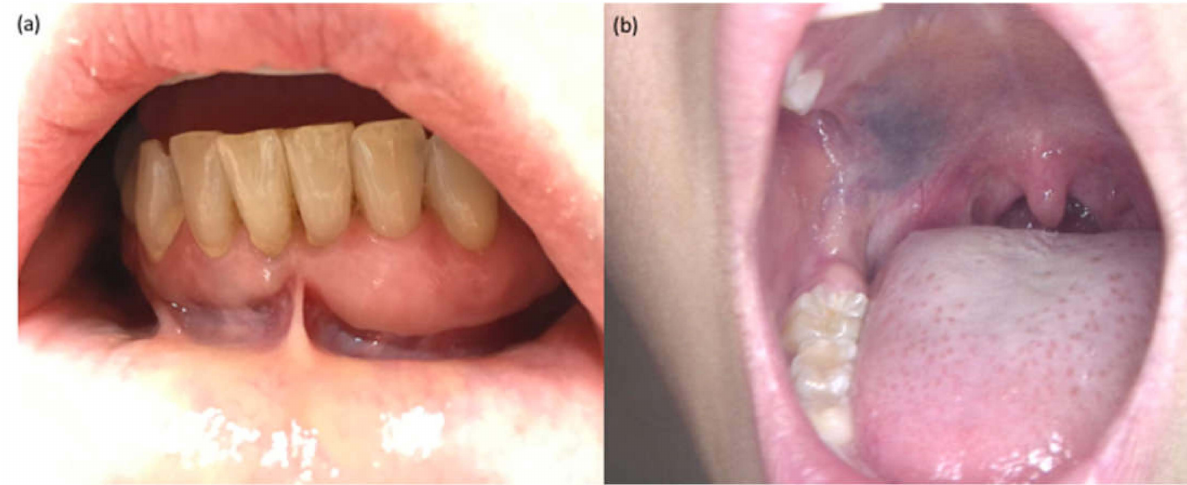
Figure 2. Clinical presentation of ( a ) benign gingival hyperplasia in a patient in treatment with a BRAF inhibitor (vemu- rafenib); ( b ) a pigmentation of the hard palate induced by